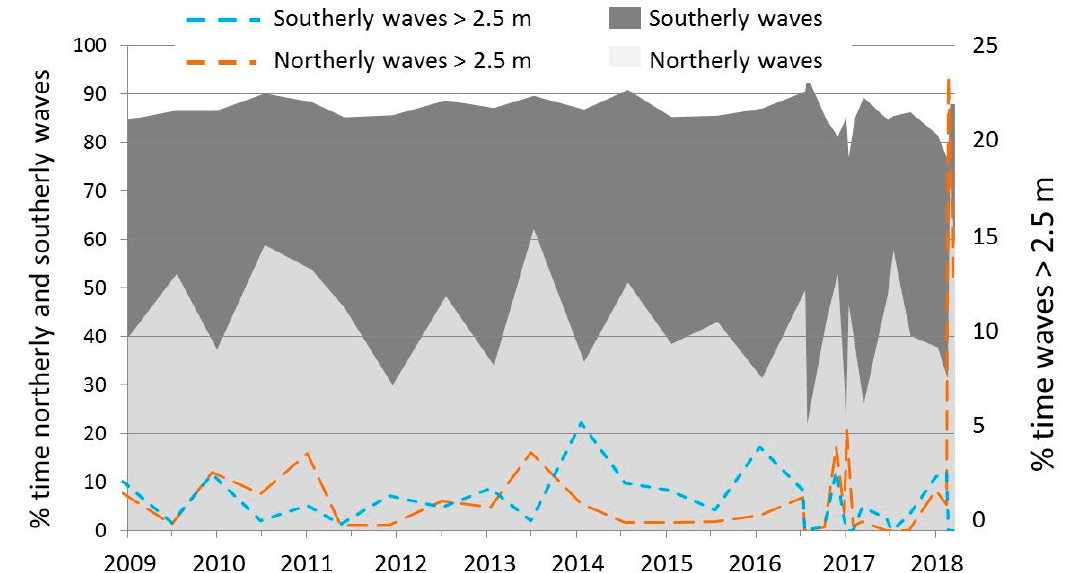
Figure 7. Percentage of time offshore waves recorded at West Gabbard approached from northerly ( Dir P : 300–60 ◦ ) and southerly ( Dir P : 120–240 ◦ ) directions and with heights above 2.5 m (calculated for periods between consecutive surveys undertaken between 7-Jan- 2009, and